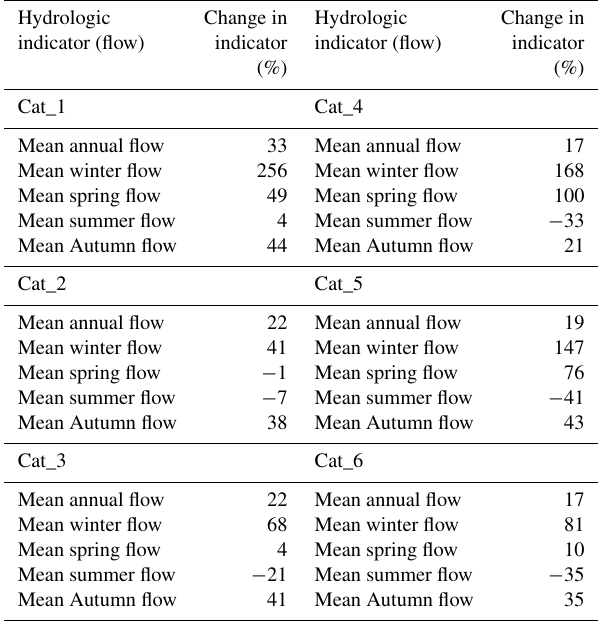
Table 6. Winter–spring and autumn center of volume (CV) dates for the six study